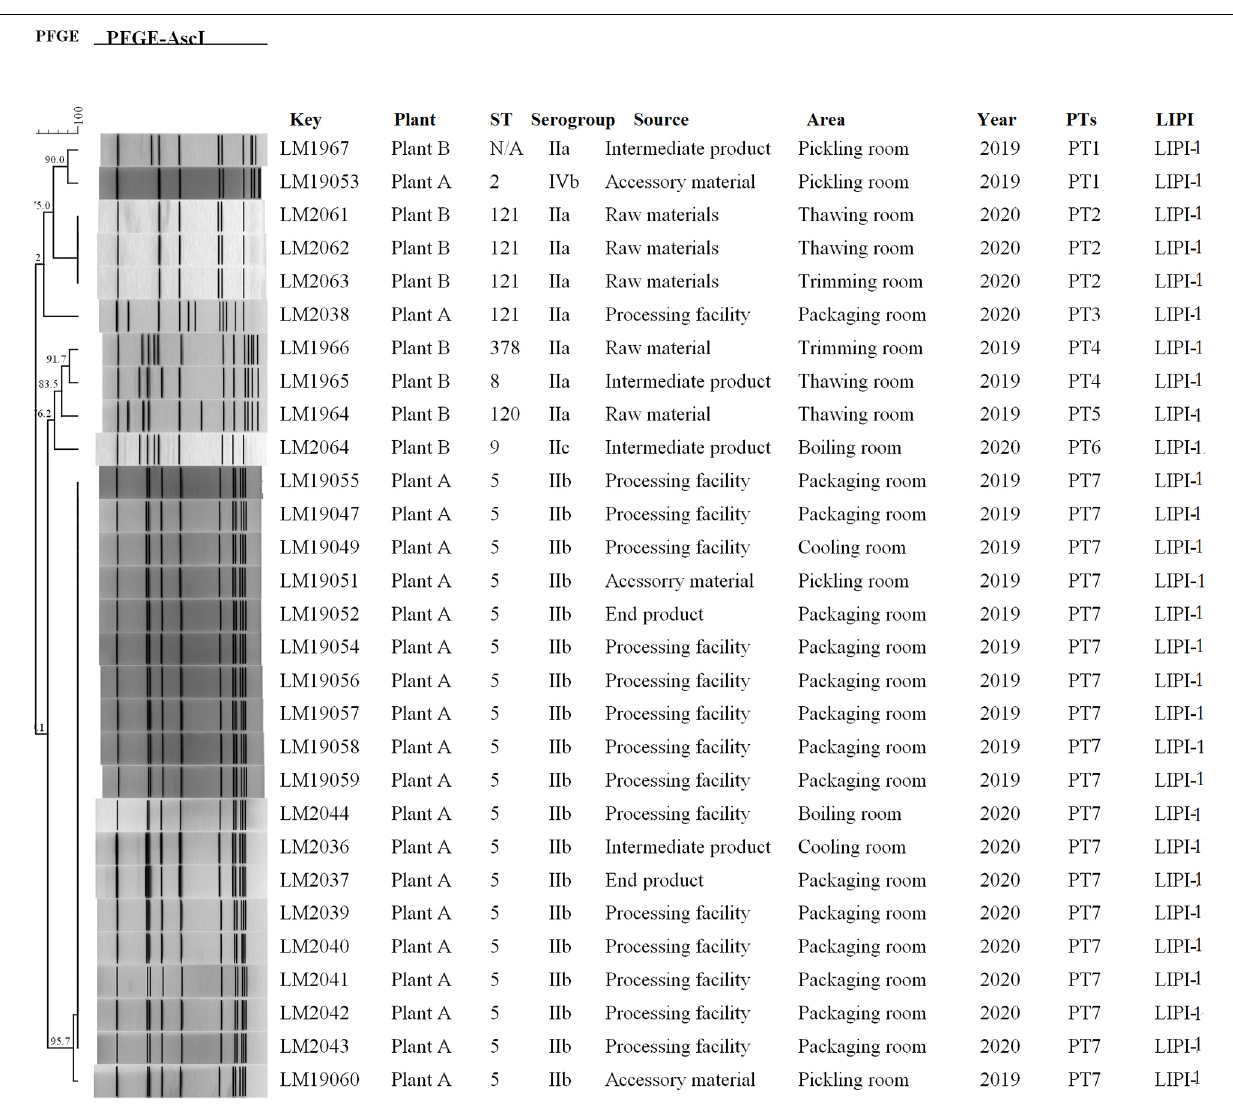
FIGURE 1 | Relationships among the L. monocytogenes isolates between of PFGE. The 29 L. monocytogenes isolates were analyzed by PFGE using Asc I. The corresponding data, including the name of the isolate (Key), name of the plant (Plant), MLST type (ST), serogroup, source, area, separation time (Year), PFGE type, and pathogenic island (LIPI) type, are shown along with the dendrogram to the